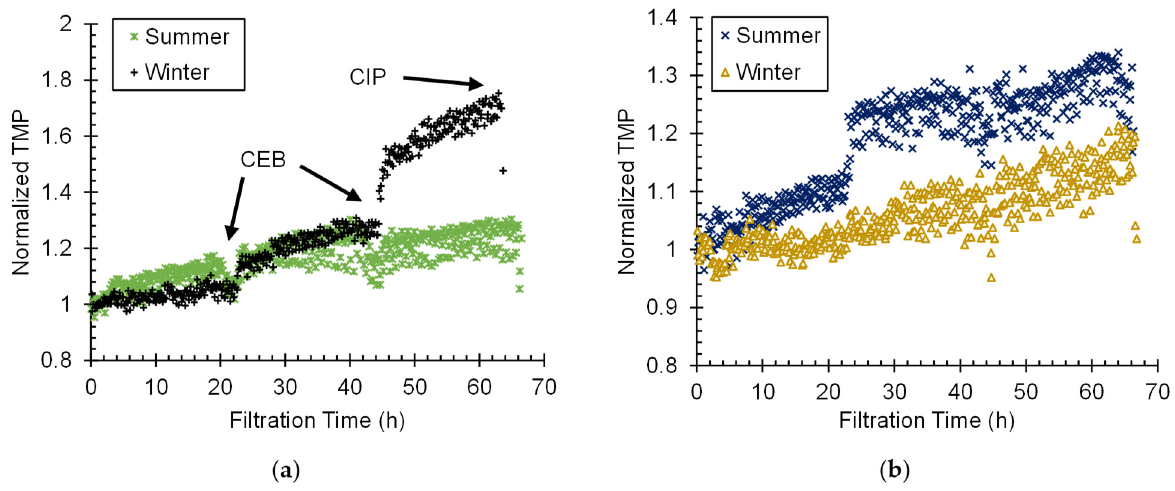
Figure 4. Comparison of summer and winter CF–IN pretreatment at alum dose of: ( a ) 27 mg L − 1 ; ( b ) 34 mg L − 1 .